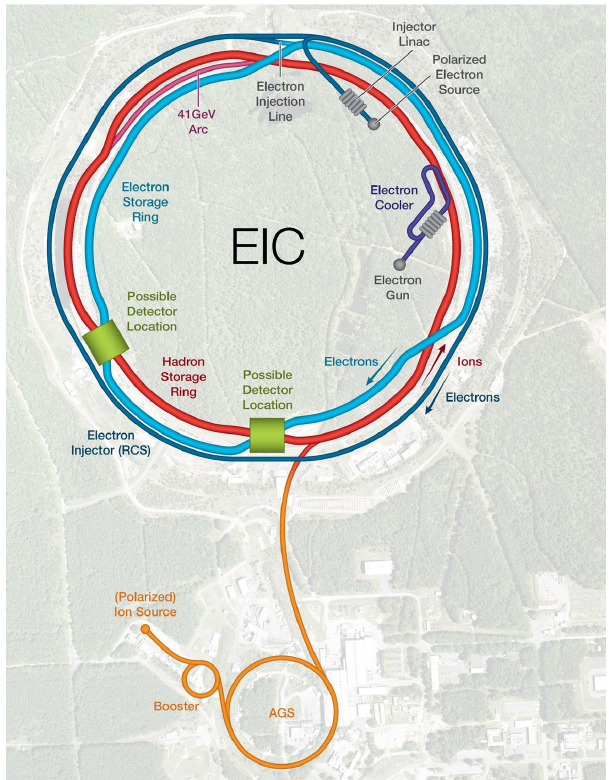
FIG. 1. Schematic layout of the EIC at Brookhaven National